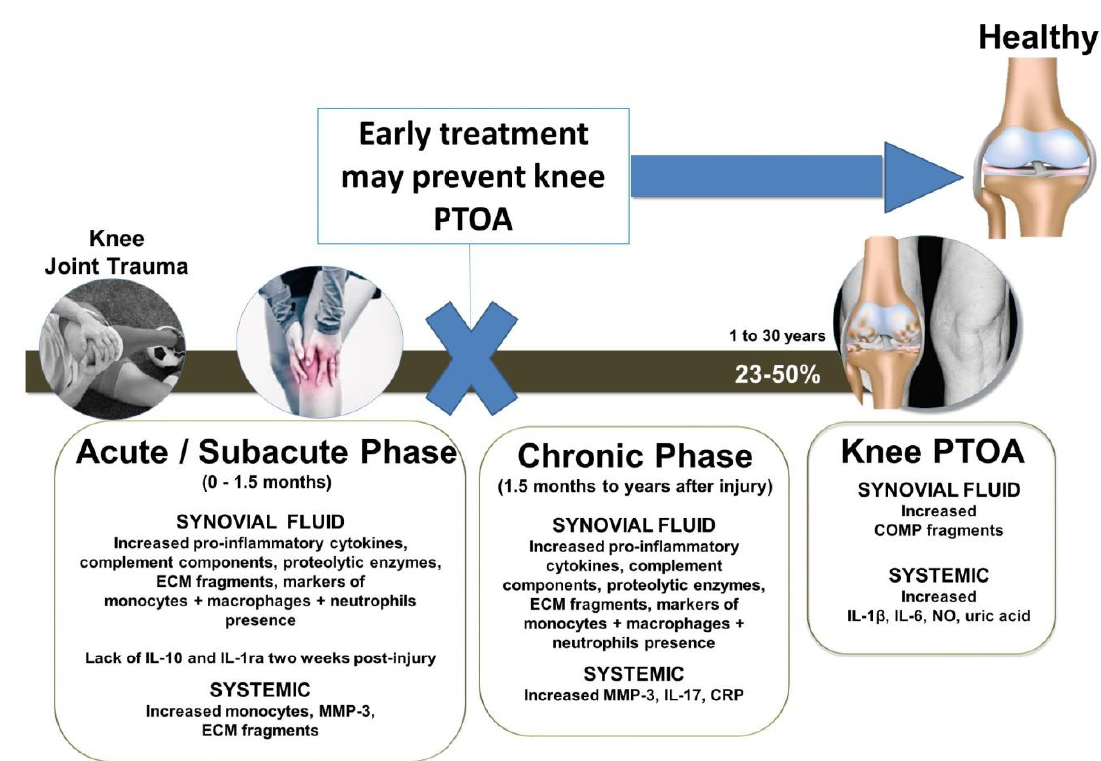
Figure 1. An early multifaceted anti-inflammatory therapeutic approach may reduce the continuous cycle of inflammation and articular cartilage degradation that often endures for months to many years following knee trauma. Whether resolution of chronic inflammation (indicated by the blue x) can be accomplished to prevent or halt the development of PTOA remains to be determined. This figure was adapted and summarized based on clinical data that demonstrated significant increases of these markers at the indicated time points after knee joint injury as discussed in detail in our systematic evidence-based review [3]. Abbreviations: cartilage oligomeric matrix protein (COMP), c reactive protein (CRP), extracellular matrix (ECM), matrix metalloproteinase 3 (MMP-3), nitric oxide (NO).